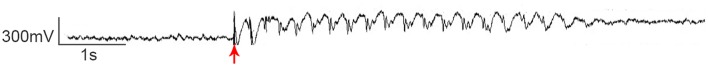
Clinically recorded self-terminating spike-wave discharges induced by transcranial magnetic stimulation. The stimulation was applied at the red arrow. Spike and wave afterdischarges are observed. Figure is visualized from Kimiskidis et al. (2015).